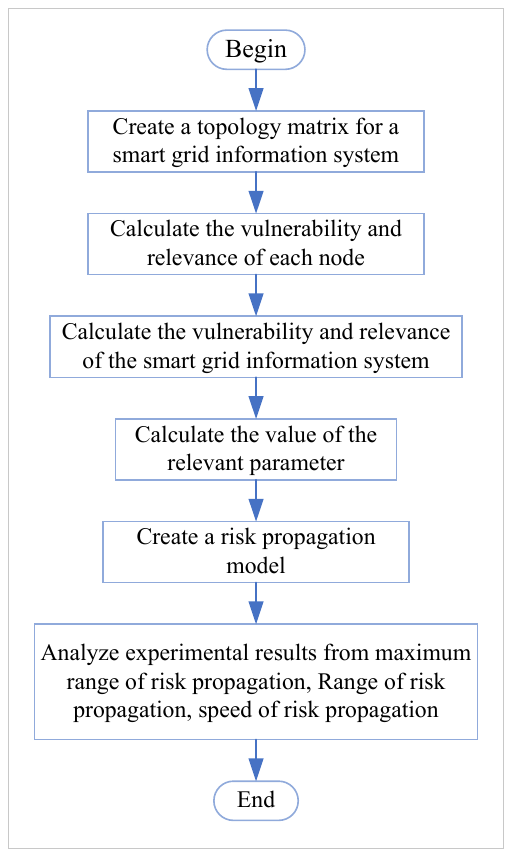
Figure 3. The workflow of the information security risk propagation model based on the Susceptible–Exposed–Infected–Recovered infectious disease model